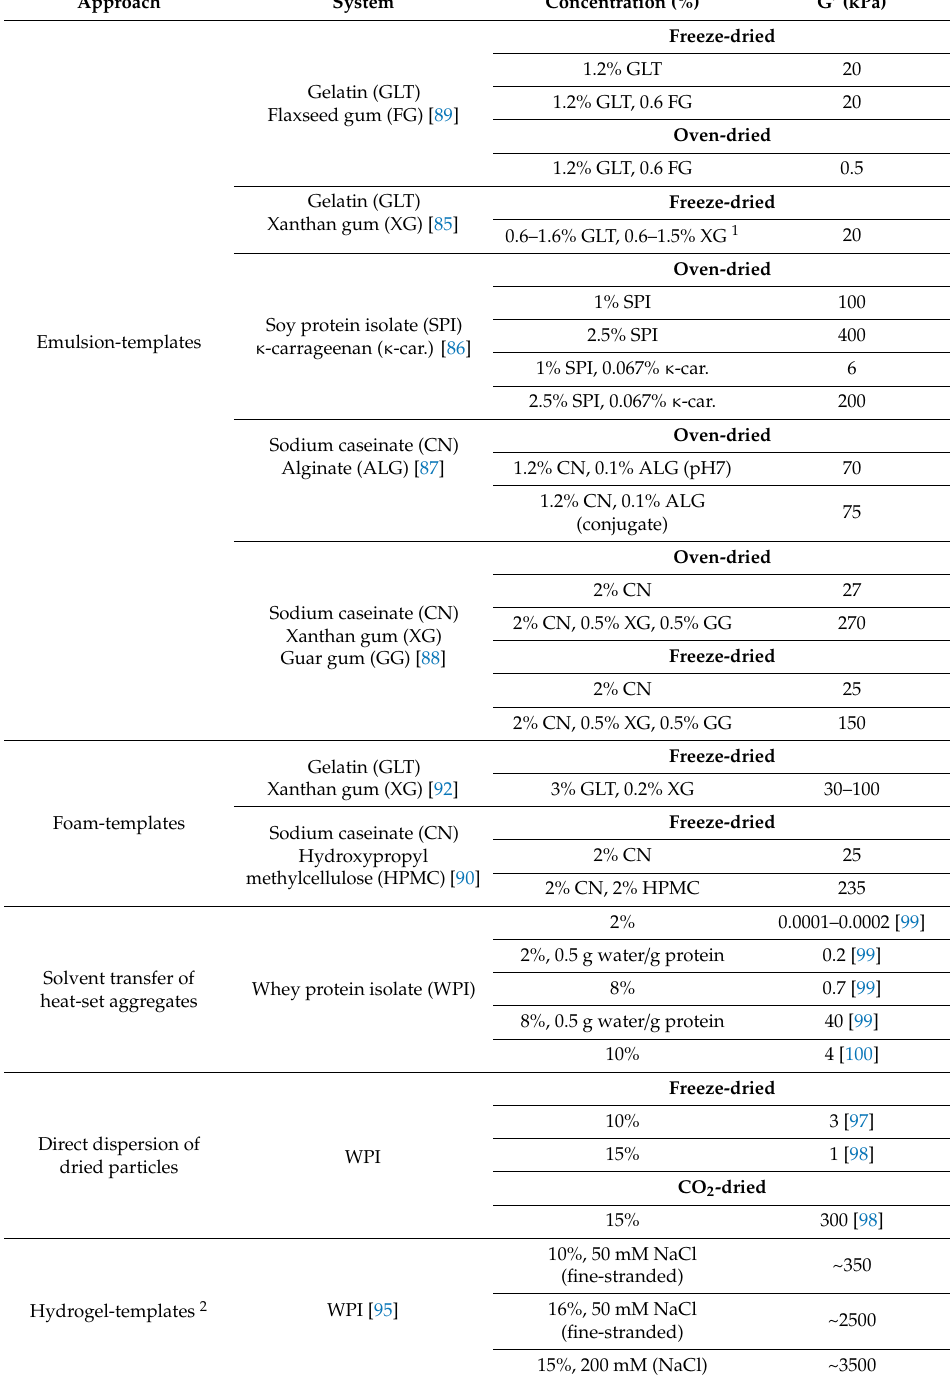
Table 1. Examples of G’-values of protein oleogels prepared by di ff erent methods, measured by oscillatory